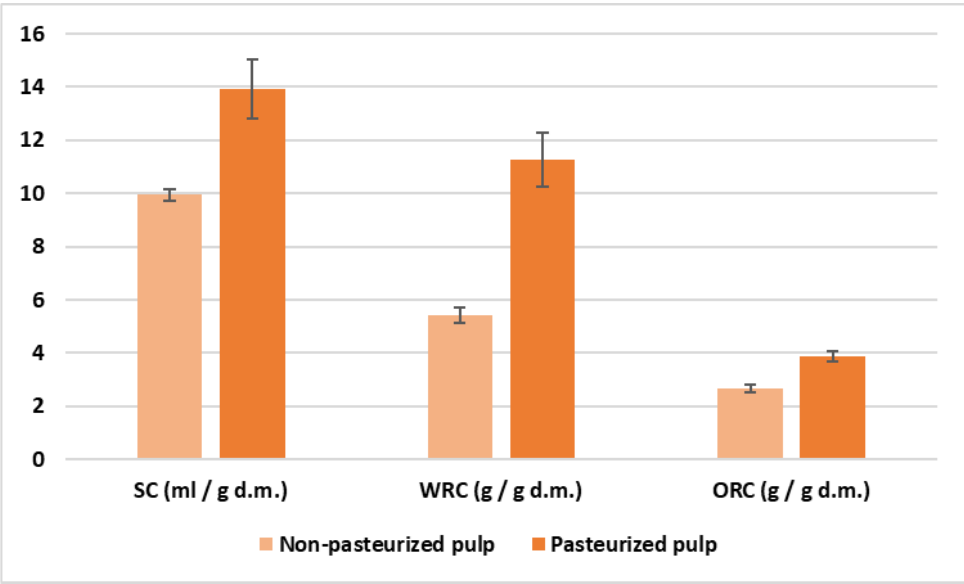
Figure 1. Physicochemical properties of non-pasteurized and pasteurized orange pulp by-products. SC: Swelling capacity; WRC: Water retention capacity; ORC: Oil retention capacity; d.m.: dry matter. TPC of the samples were similar (NPP: 5.72 ± 0.21; PP: 5.44 ± 0.13 mg gallic acid/g